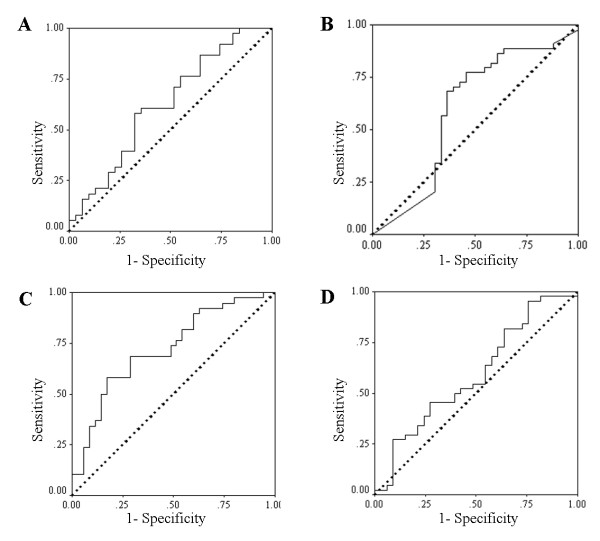
ROC curve analyses of CEA, CA19-9, MMP-9 and MMP-7 for the diagnosis of cholangiocarcinoma. The diagnostic accuracy of each biomarker, in terms of its sensitivity and specificity, are presented by receiver operating characteristic (ROC) curve analysis. Figures 2A, 2B, 2C and 2D correspond to CEA, CA19-9, MMP-7 and MMP-9. Only the area under the curve (AUC) of the ROC for MMP-7 is significantly higher than a chance value (0.5).